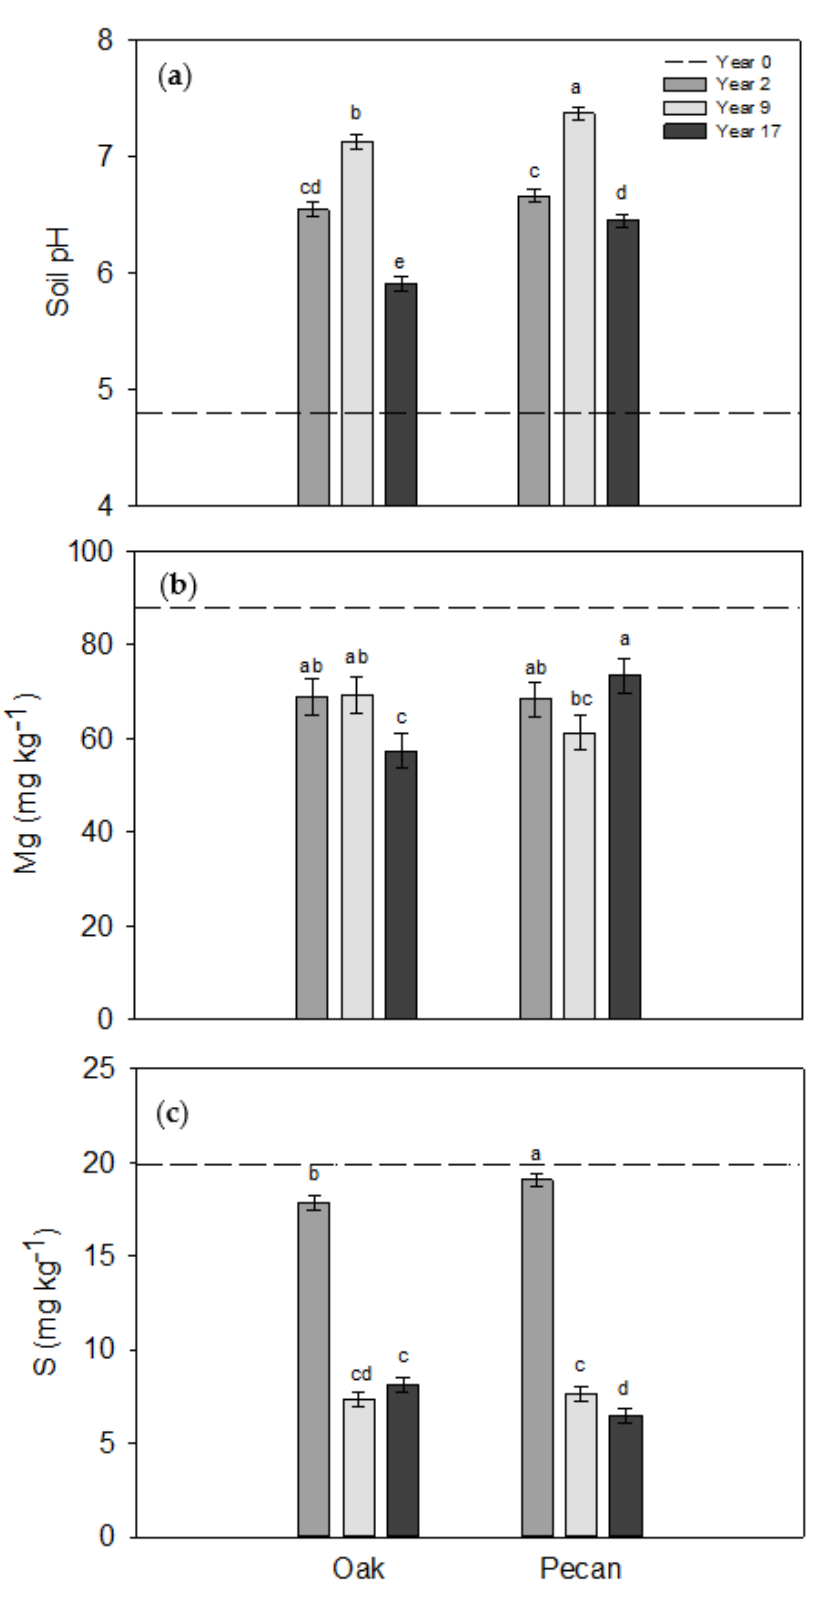
Figure 2. Selected soil chemical properties over time in a 17-year agroforestry site in Fayetteville, AR, per tree species, averaged across fertilization treatments. Dashed lines represent baseline values (1999). Means followed by the same letter within a panel do not differ at p < 0.05. ( a ) Soil pH; ( b ) Mg concentration in soil (mg kg -1 ); ( c ) S concentration in soil (mg kg -1